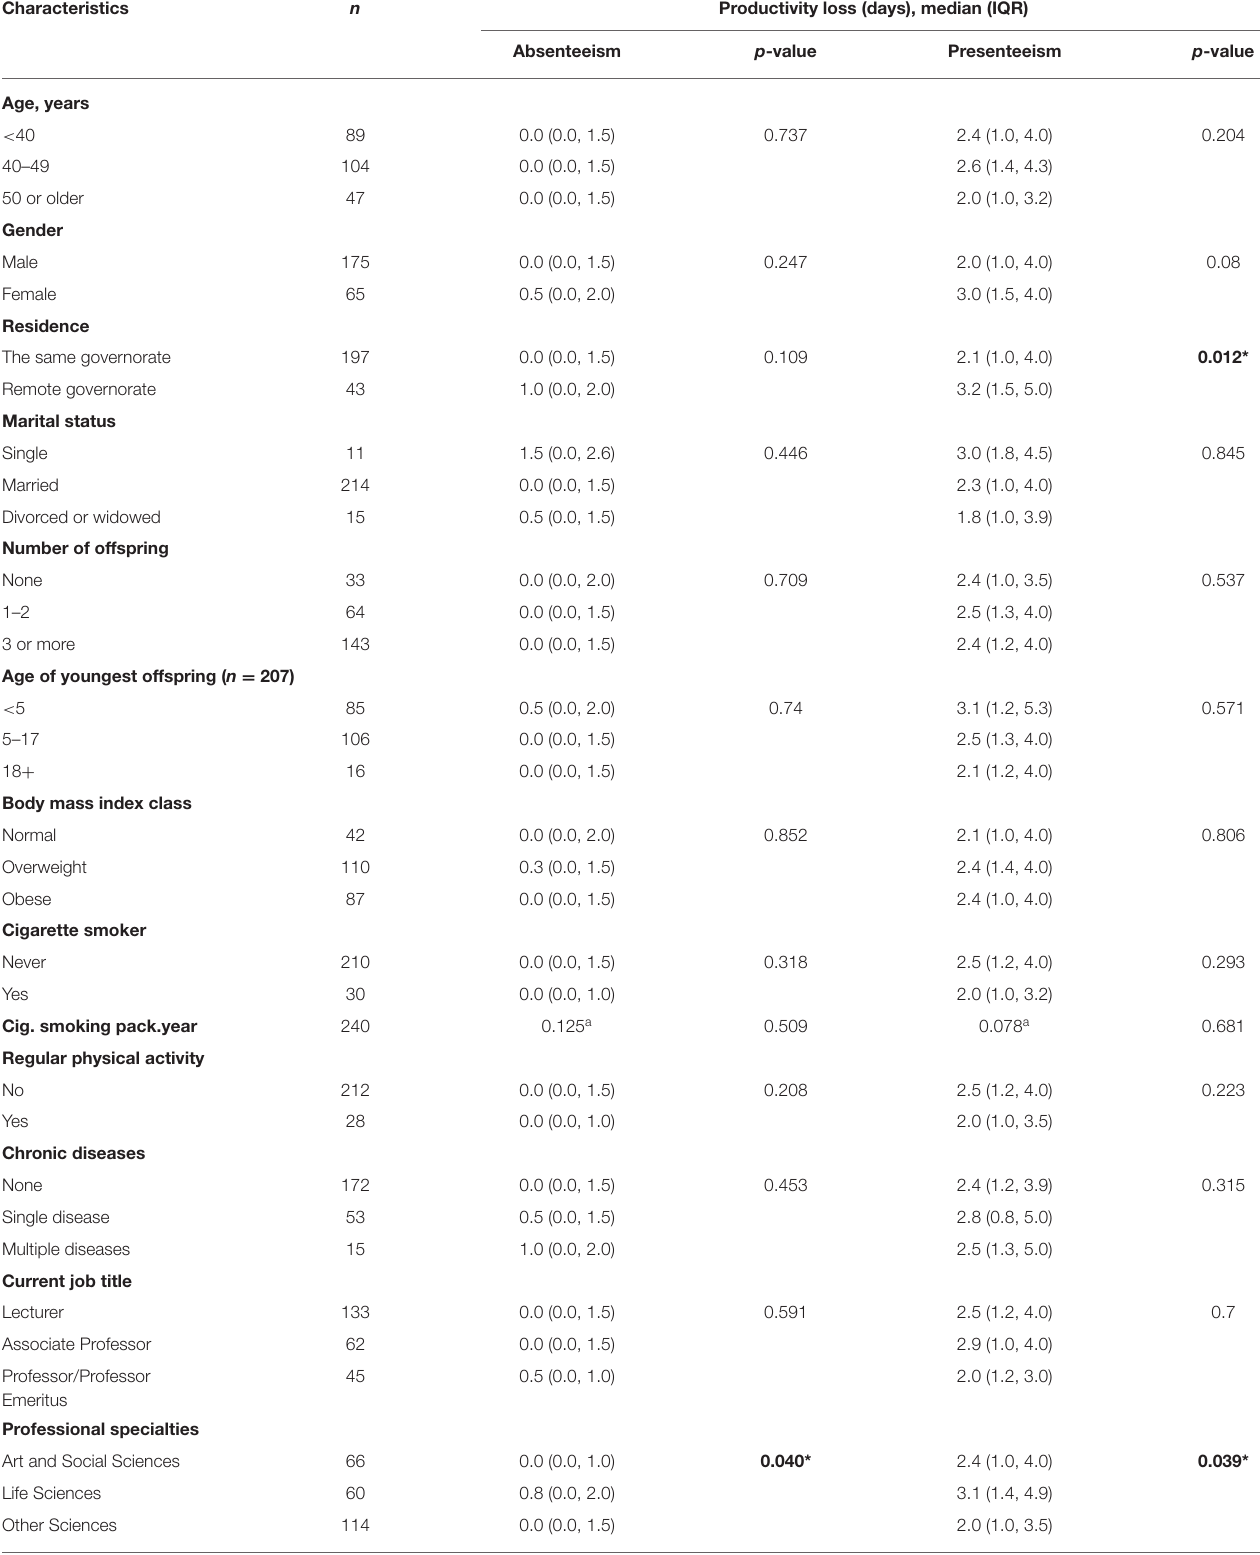
TABLE 2 | Distribution of respondents’ absenteeism and presenteeism days by their demographic, health, and work characteristics ( N = 240).